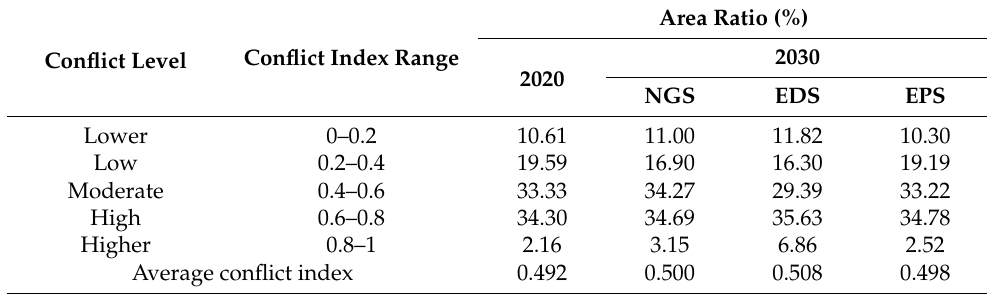
Table 2. Statistics for LUCs index